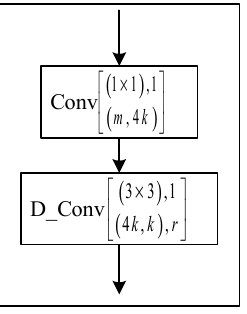
Figure 5. The construction of the D-layer.